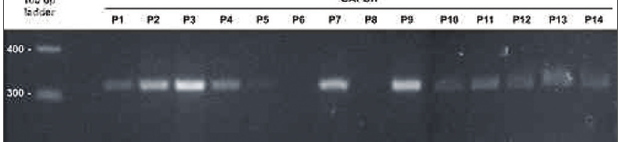
Figura 1. Amplificação de GAPDH utilizando volumes fixos das prepa- rações de RNA. Análise por eletroforese em gel de agarose 2% corado por brometo de etídio. Padrão de peso molecular = 100 bp ladder. P1-P14: pacientes 1 a 14.